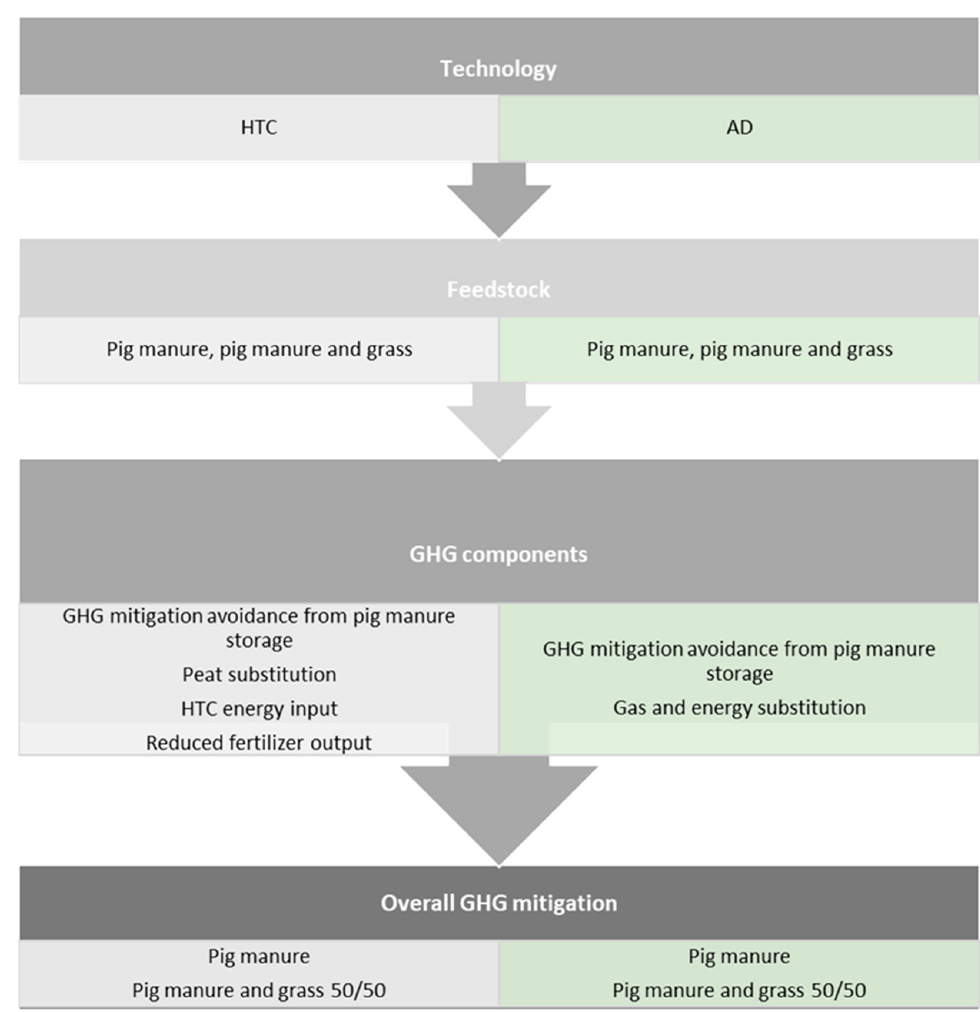
Figure 1. GHG mitigation scenarios explored.